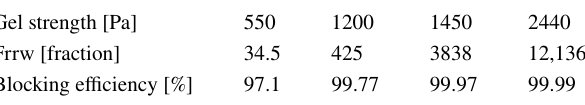
Table 4 A summary of gel strength, Frrw, and blocking efficiency Gel strength [Pa]